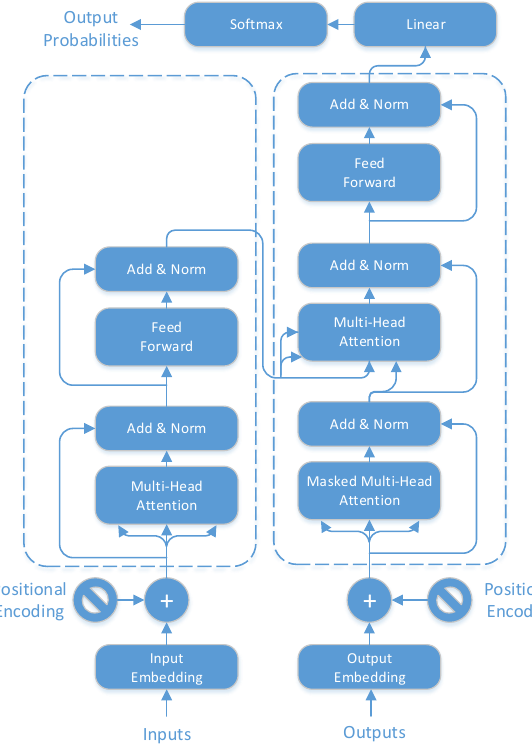
Figure 3. The Transformer model